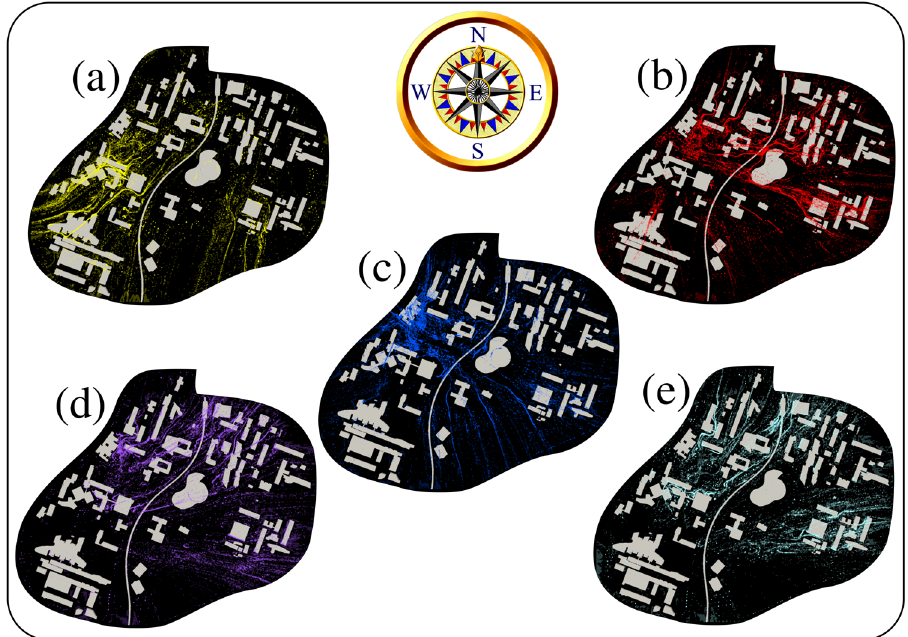
Figure 3. Effect of weather conditions and urban infrastructure on airborne pollen aerodynamics outdoors in a university campus. Computational results at t = 6 min are shown from a top-view 3D perspective. ( a ) 06/04/2020 (yellow-colored grains); ( b ) 07/04/2020 (red-colored grains); ( c ) 08/04/2020 (blue-colored grains); ( d ) 09/04/2020 (magenta-colored grains); ( e ) 10/04/2020 (cyan-colored grains); see Table 1. The initial number of pollen grains, in this case, is n max ≈ 0.4 × 10 6 . For the complete aerodynamics at all time steps, see the multimedia video files: Video 1, Video 2 and Video 3.